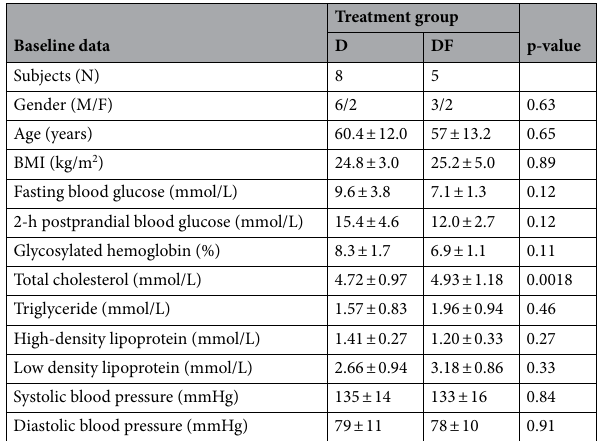
Table 1. Baseline characteristics of subjects that completed the study (N = 13). Values are expressed as means ± standard deviation. D diet-only, DF diet-FMT. Two-tailed Student’s t test for independent-samples were used to compare anthropometric values and biochemical values between